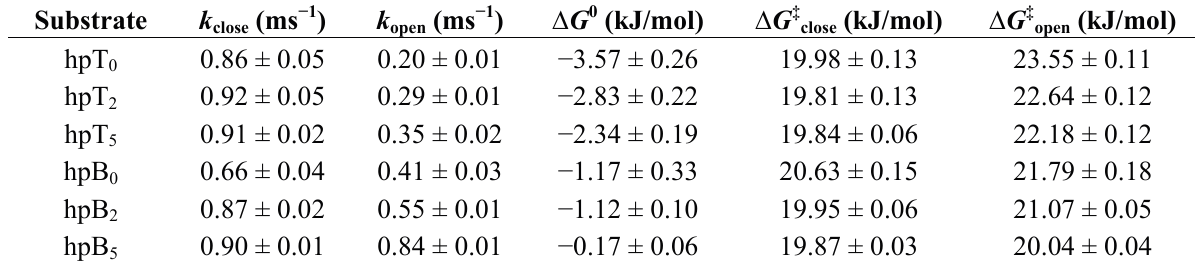
Table 2. The opening and closing rates of the DNA hairpin constructs, the related changes in Gibbs free energy ( ∆ G 0 ) and the transition state free energy barriers ( ∆ G ‡